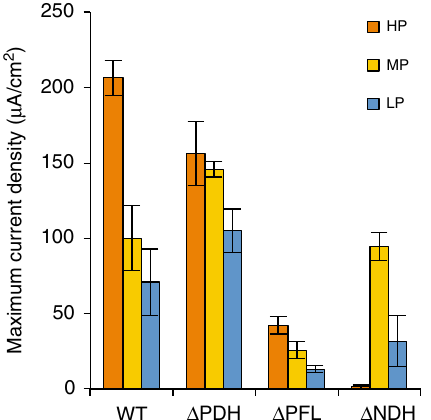
Fig. 3 Current generation from pyruvate by WT and mutant S. oneidensis strains. The maximum current densities at + 0.5 V (HP), + 0.2 V (MP), or 0 V (LP) are shown. Bars and error bars represent means and s.d., respectively ( n = 3 biological